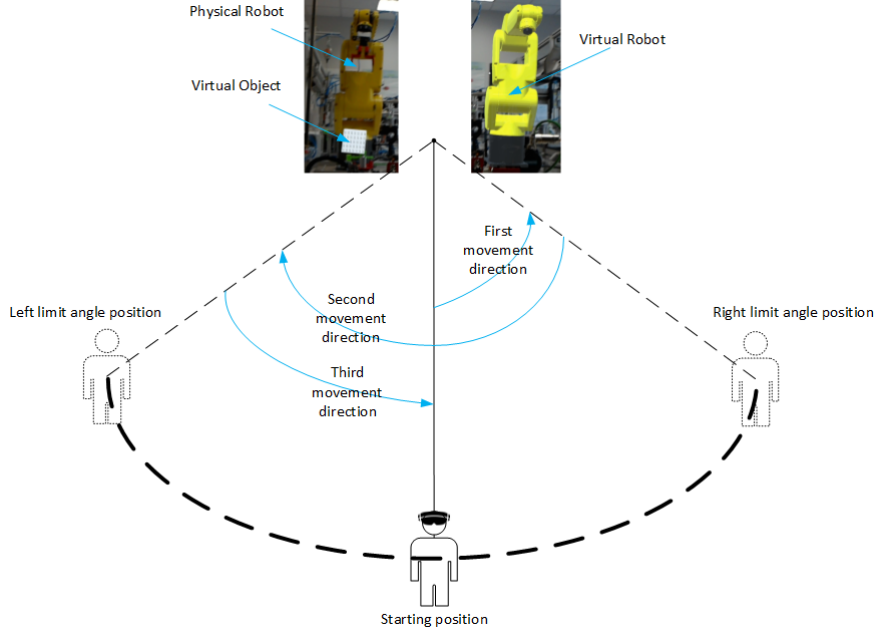
Figure 9. Schematic diagram of an experiment to evaluate the effect of operator motion on the accuracy of distance measurements between test